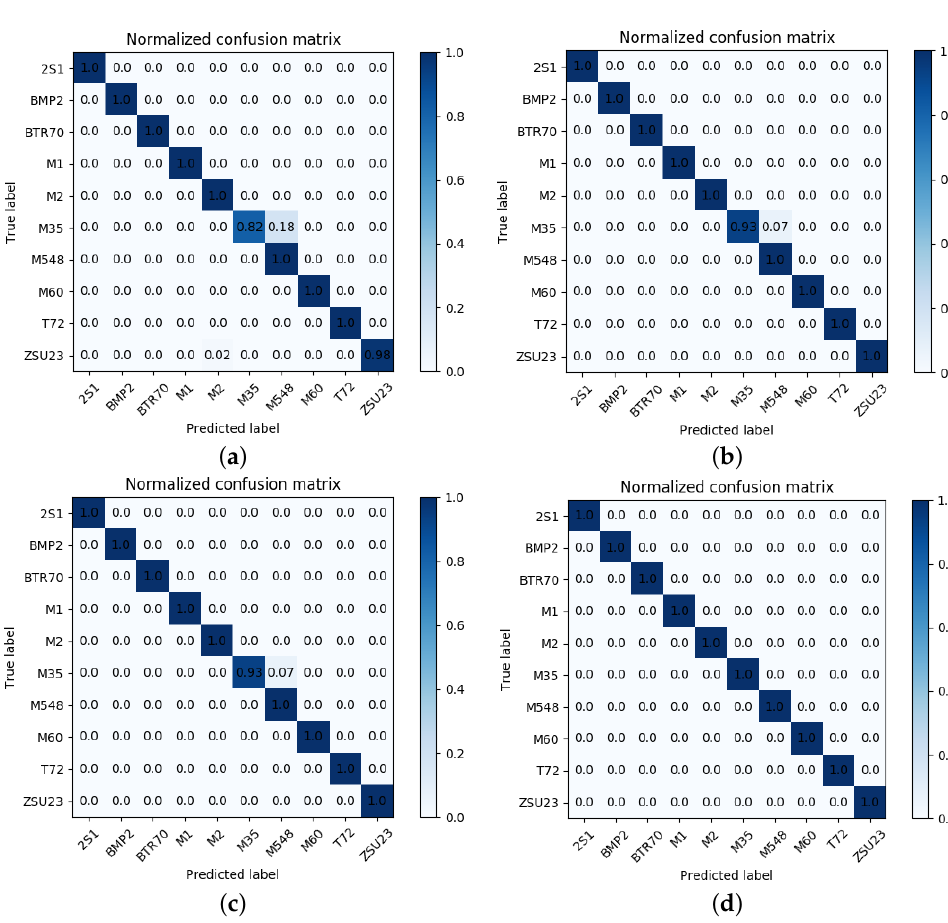
Figure 11. Confusion matrices of the pseudo-labeled dataset. ( a ) Before label denoising. ( b ) Label denoising using COSS. ( c ) Label denoising using NMIS. ( d ) Label denoising using SSIM.